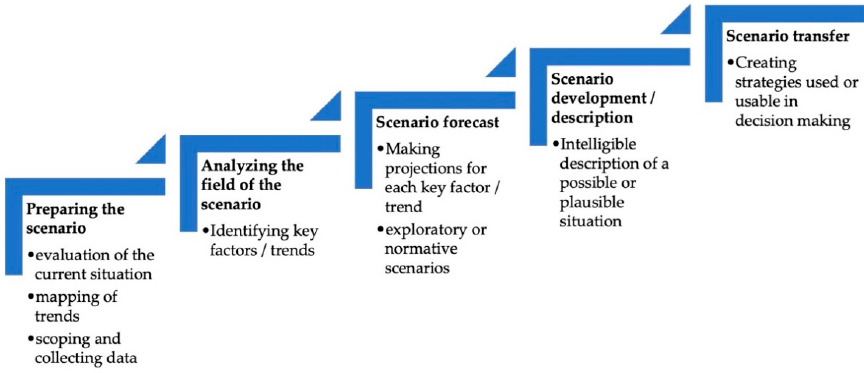
Figure 4. Stages of scenario management based on the works of [81–83].